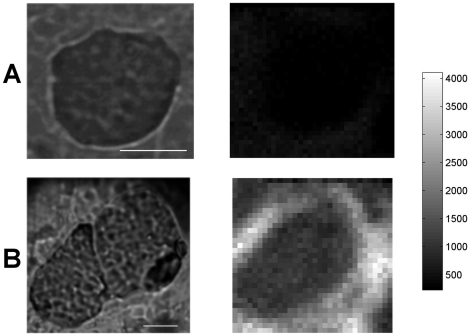
Transmission image (left) and maps of the 390–440 nm peak area
(right) of control (A) and ofloxacin treated (B) vegetation
maps.The grayscale was the same for both fluorescence maps. White bar
 = 10 µm.